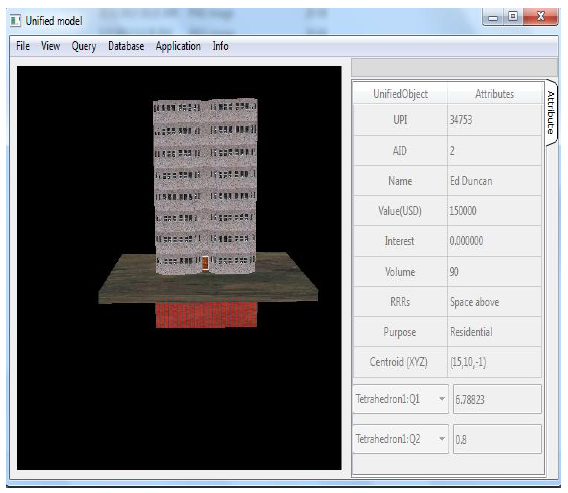
Figure 8. A textured unified block for 3D